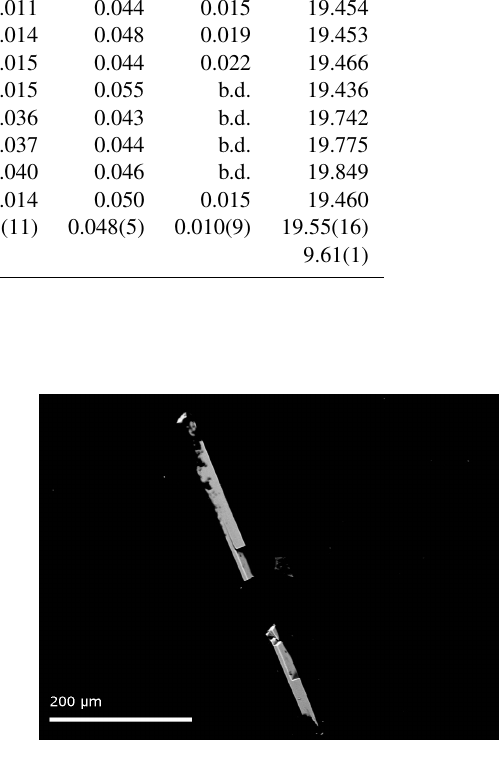
Figure 2. Backscattered electron image of the single-crystal mullite-2 c from the microprobe analysis. The acicular crystal broke into two pieces during the